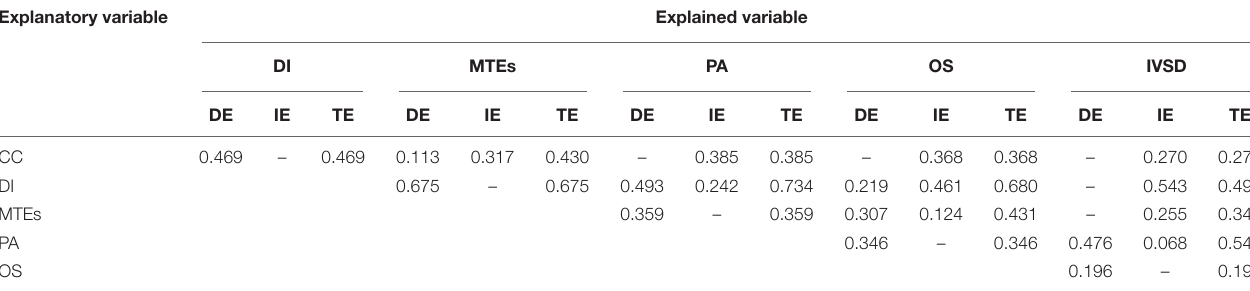
TABLE 5 | Effect deconstruction of structural model (standardized